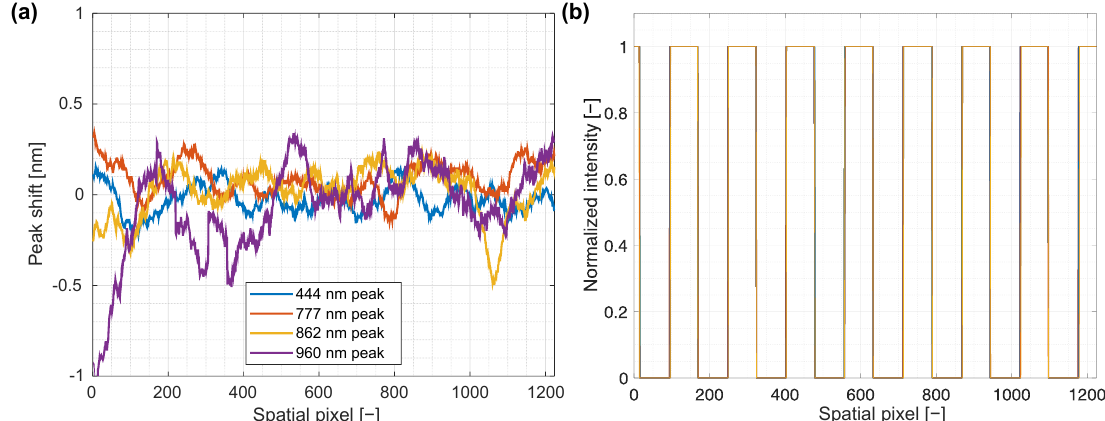
Figure 7. ( a ) To determine spectral smile, pixel coordinates of maxima in the spectra corresponding to peaks of different LEDs comprising the illumination were tracked at different spatial coordinates, and the offset from the wavelength at the center of the FOV was calculated. To improve signal-to-noise ratio, a running average of 50 elements was applied to the calculated shifts. ( b ) An example of keystone deformation determination for a 50 mm objective lens shows a view across the spatial axis of an HSI of a square grid pattern. Cross-sections at different wavelengths are plotted on the same graph with different colors, showing an almost perfect